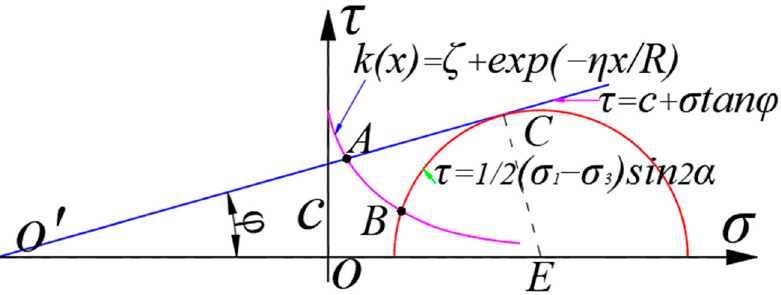
Figure 6. Relationship between expanded convergence function, shear strength and M-C.